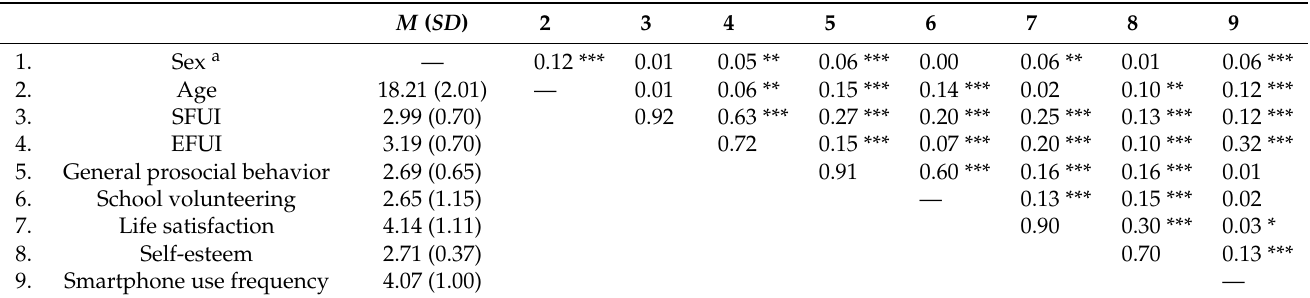
Table 1. Summary of Means, Standard Deviations, and Intercorrelations for the Variables of Interest ( N =